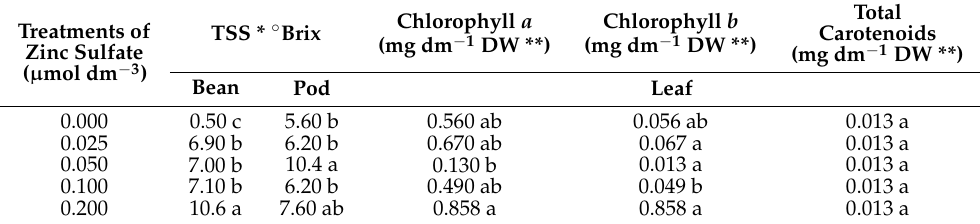
Table 4. Average of the variables total soluble solids (TSS), chlorophyll a , chlorophyll b , and